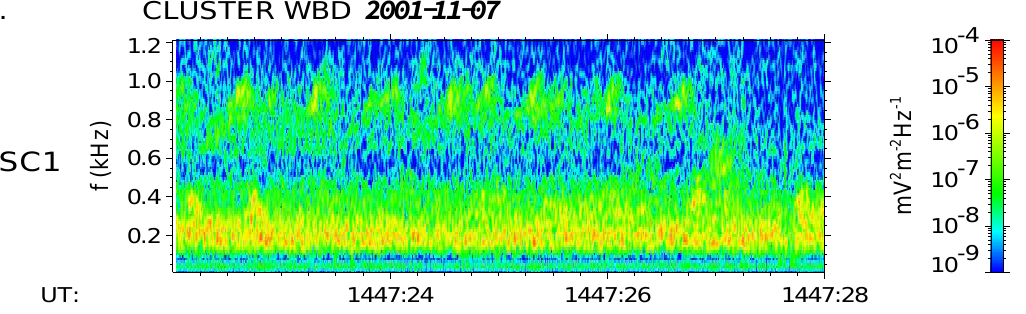
Fig. 10. Spectrogram of one electric component recorded by WBD on 7 November 2001 between 14:47:22 and 14:47:28UT for SC1.